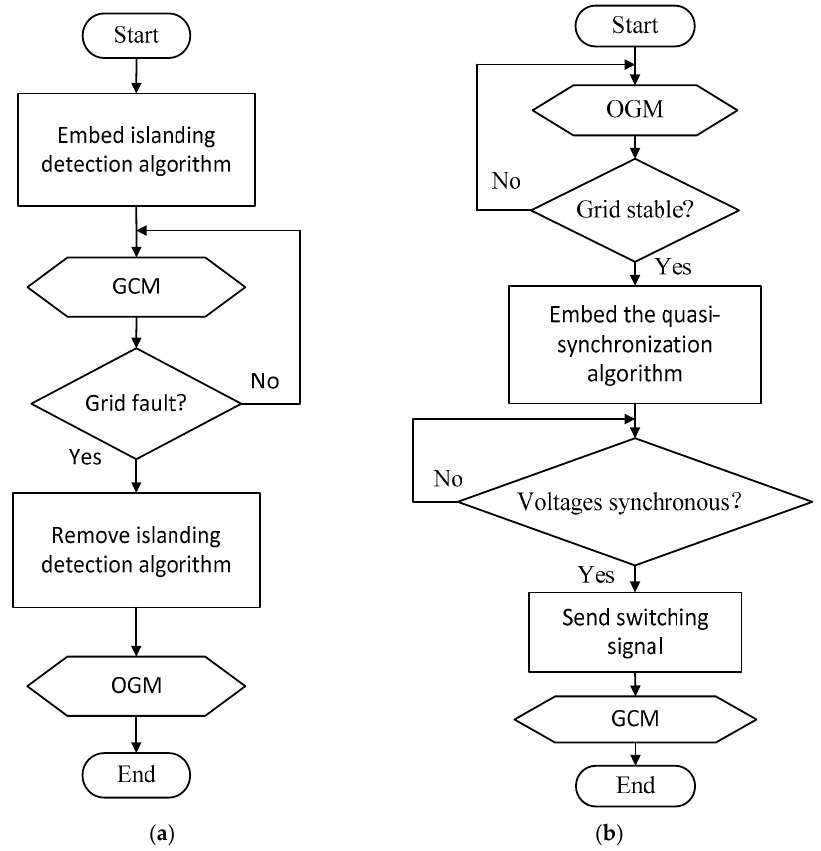
Figure 2. The diagram of integrated switching control strategy between two modes: ( a ) Switching from GCM to OGM; ( b ) Switching from OGM to GCM.